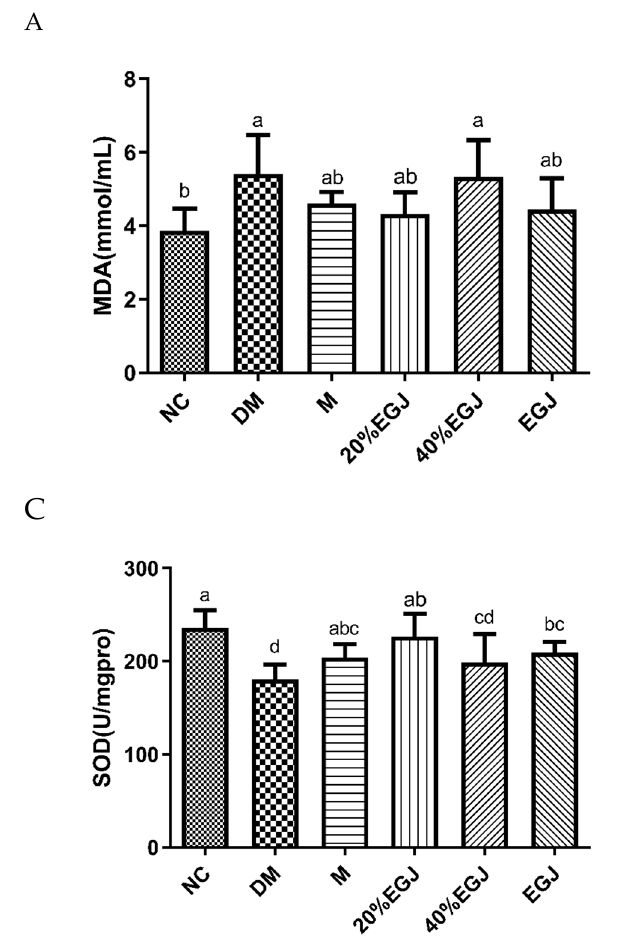
Figure 13. ( A – C ) stands for the MDA, CAT, and SOD of the mice in each group, respectively. Note: the data were expressed as the mean ± the SD ( n = 9) and the different letters marked above the bars showed the significant differences from the ANOVA multiple test ( p <